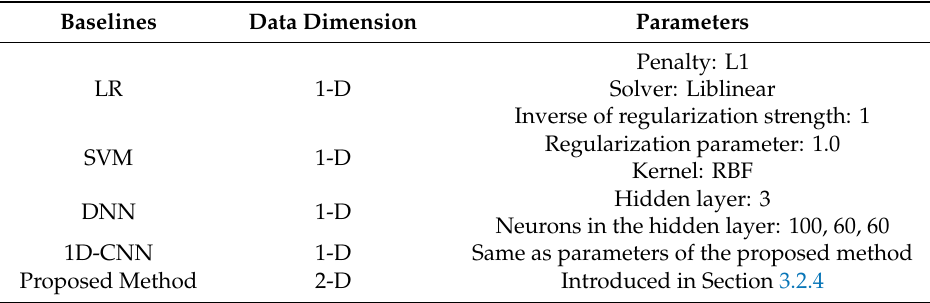
Table 2. Parameter settings.